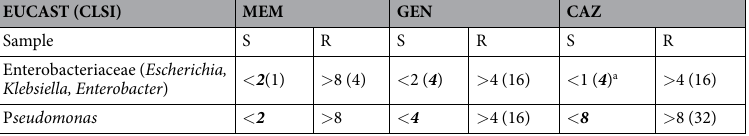
Table 2. Summary of clinical breakpoint values (given in µ g/mL) for antibiotics directed against Gram- negative bacteria. CLSI breakpoints are in parentheses, if different from EUCAST. a Both 2 µ g/mL and 4 µ g/mL concentrations were used.